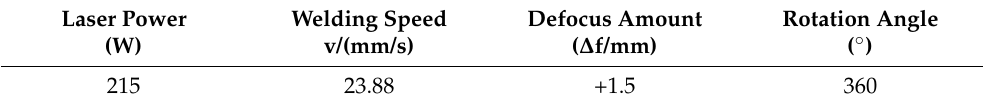
Table 2. Laser welding process parameters.